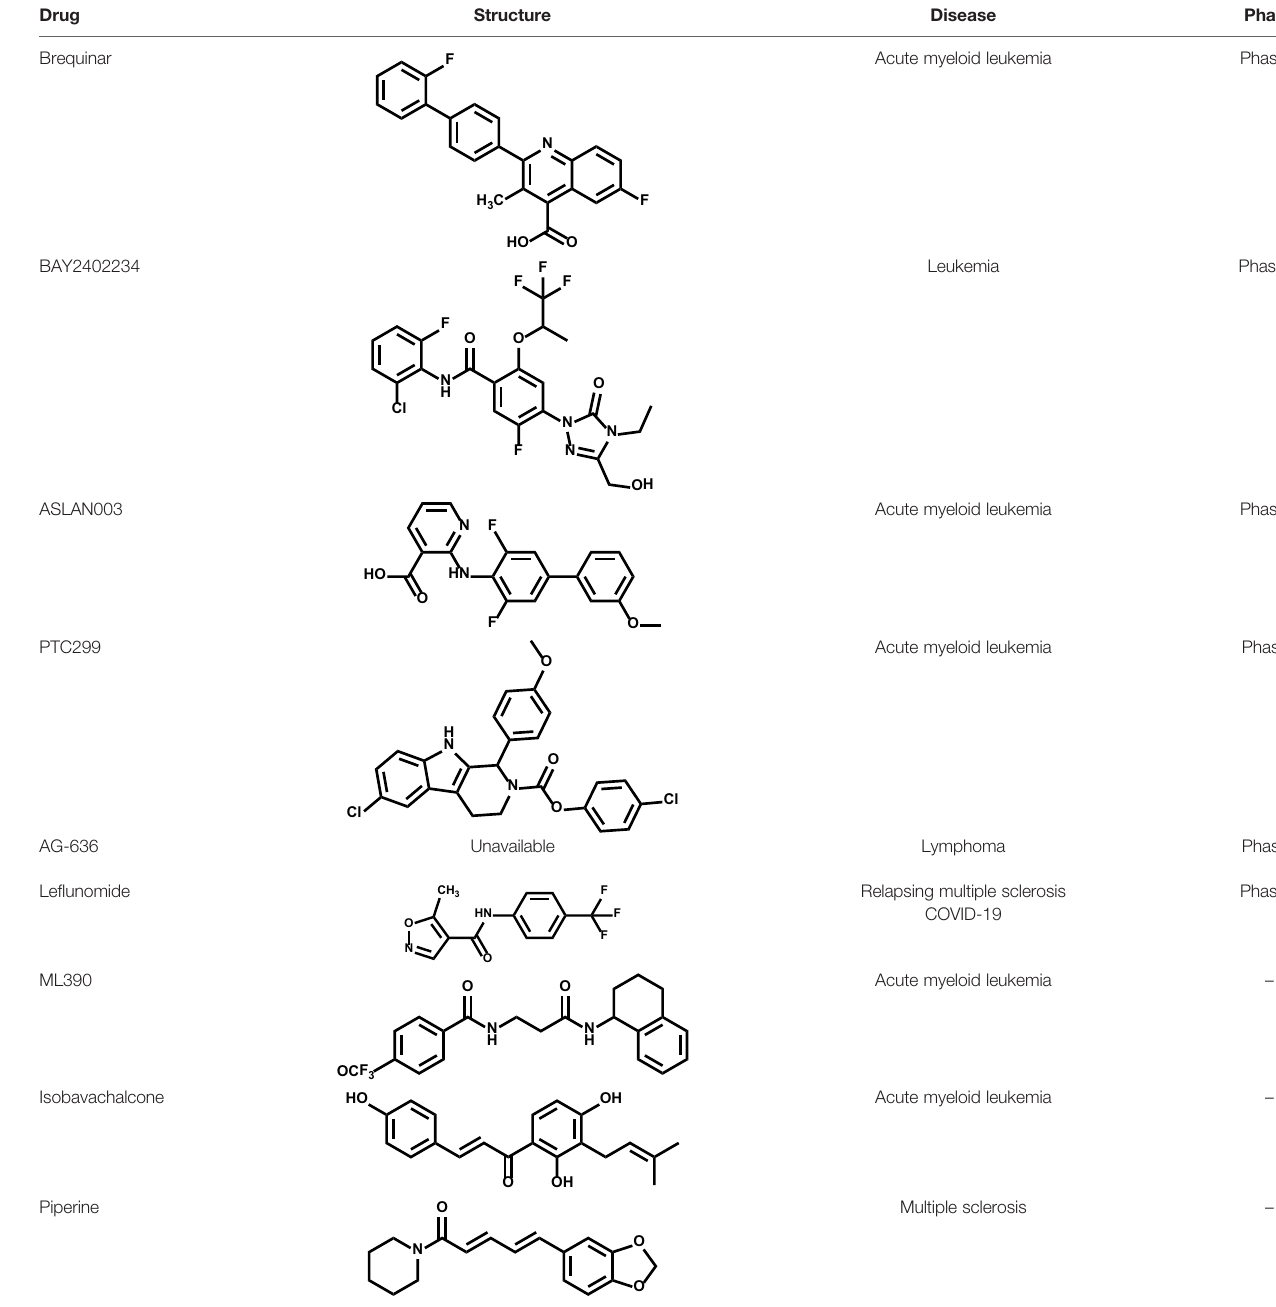
TABLE 2 | Representative small-molecular inhibitors of DHODH. Drug